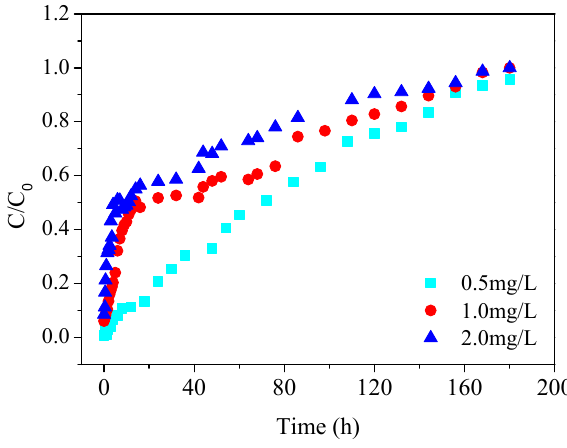
Figure 8. The breakthrough curve for varying inlet concentration (mg/L) at a bed depth of 20 cm and a residence time of 10 min. Table 6. The comparison of sorption capacity obtained from the batch system and column